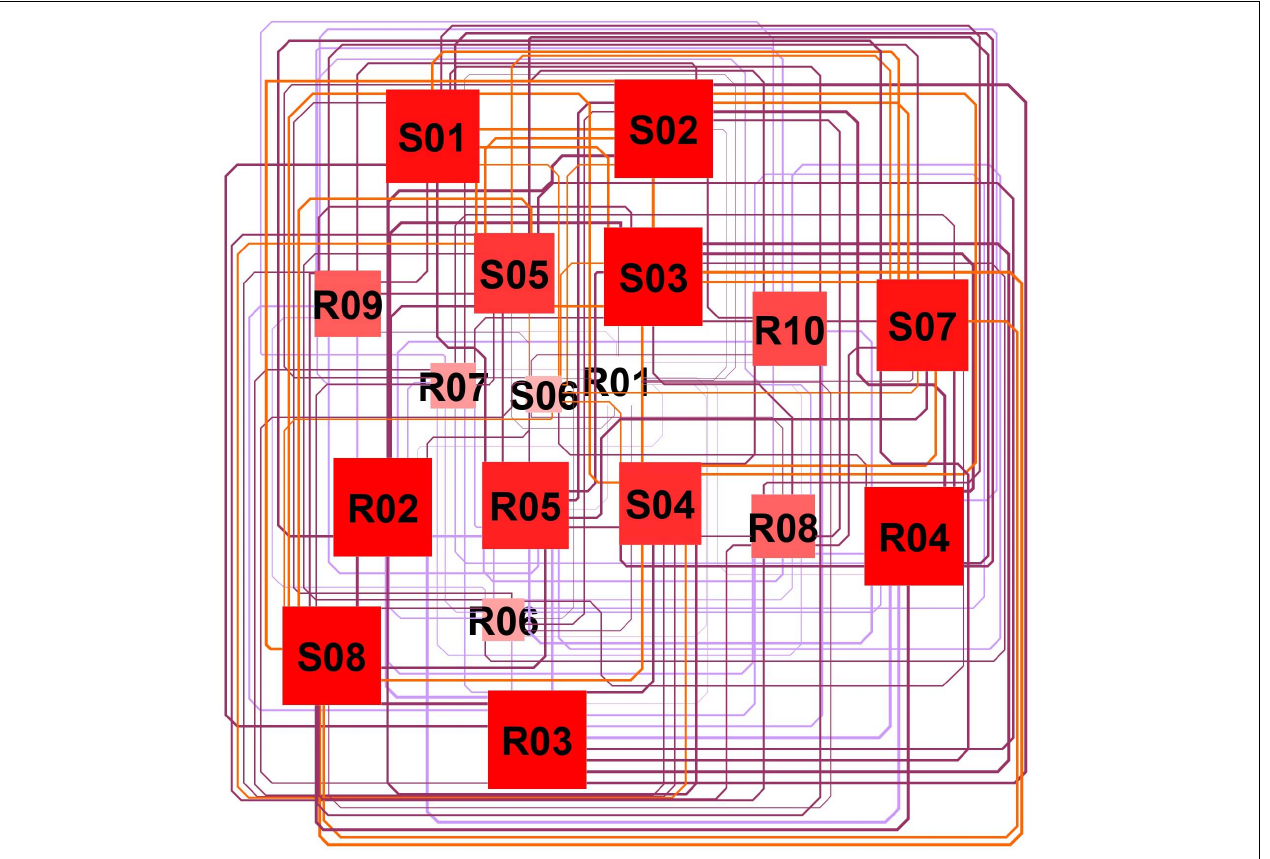
FIGURE 6 | Network of the regional and Solomon Island’s policies. Policy nodes with higher level of interlinkages are larger; links with higher weights (not shown) are thicker. Regional to regional (resp. Solomon Islands to Solomon Islands) policies are in light purple (resp. orange); links between regional and Solomon Islands policies are in dark